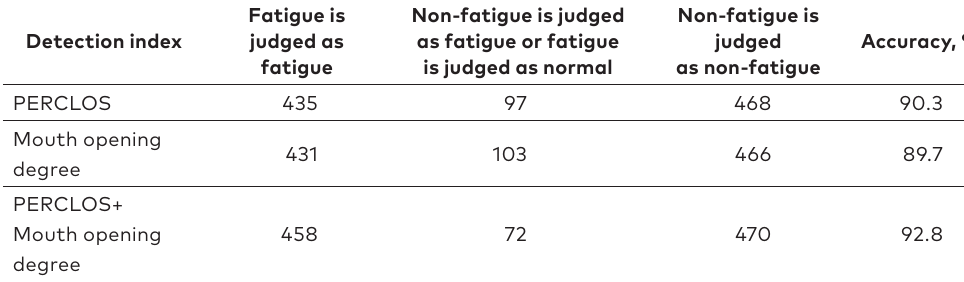
Table 4. Comparison of results of the single-index and fusion-index methods